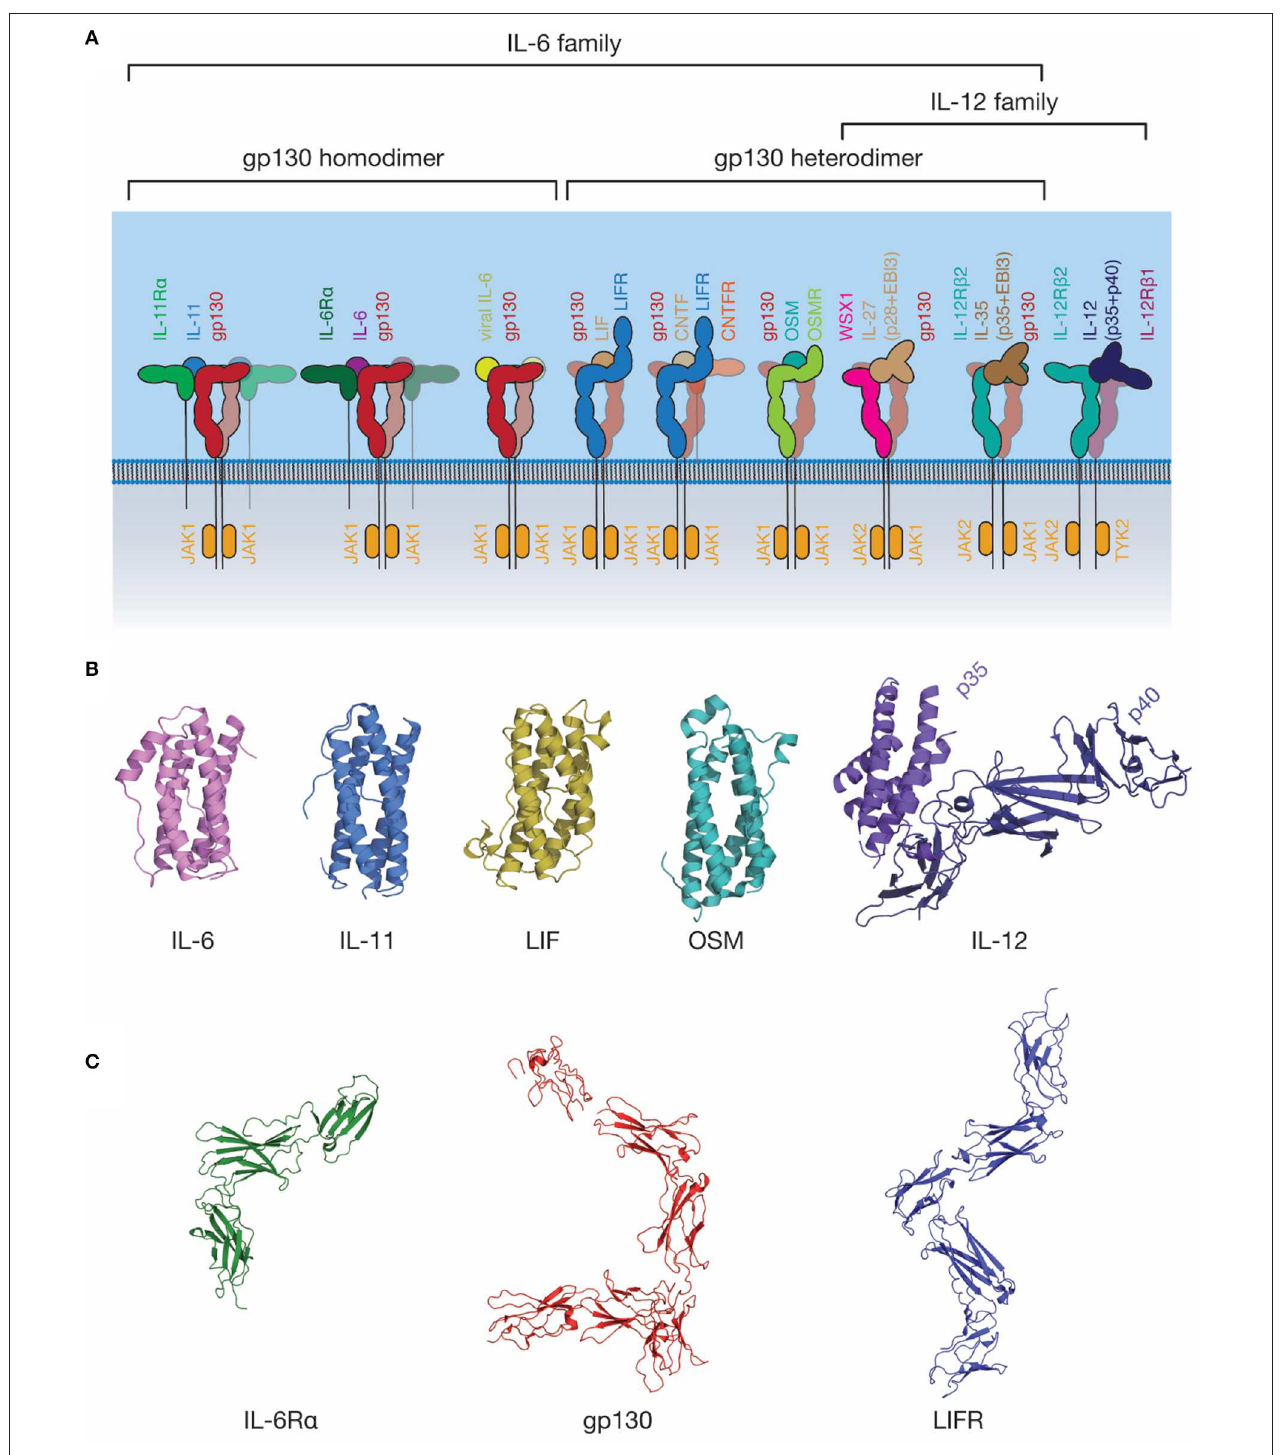
FIGURE 3 | The IL-6 family of cytokines. (A) A schematic representation of selected IL-6 and IL-12 family cytokine-receptor complexes, illustrating the diversity in the stoichiometry of signaling complexes employed. Indicative JAK family members utilized by each signal transducing receptor are shown. (B) The structures of several IL-6 and IL-12 family cytokines: IL-6 [PDB ID: 1ALU (45)]; IL-11, [PDB ID: 4MHL (98)]; LIF [PDB ID: 1LKI (99)]; OSM [PDB ID: 1EVS (100)]; IL-12 [PDB ID: 1F45 (54)]. (C) The structures of extracellular domains of IL-6 family cytokine receptors: IL-6R α [PDB ID: 1N26 (101)], the common signal transducing receptor, gp130 [PDB ID: 3L5H (58)] and the receptor for LIF and several other IL-6 family cytokines, LIFR [PDB ID: 3E0G (65)].